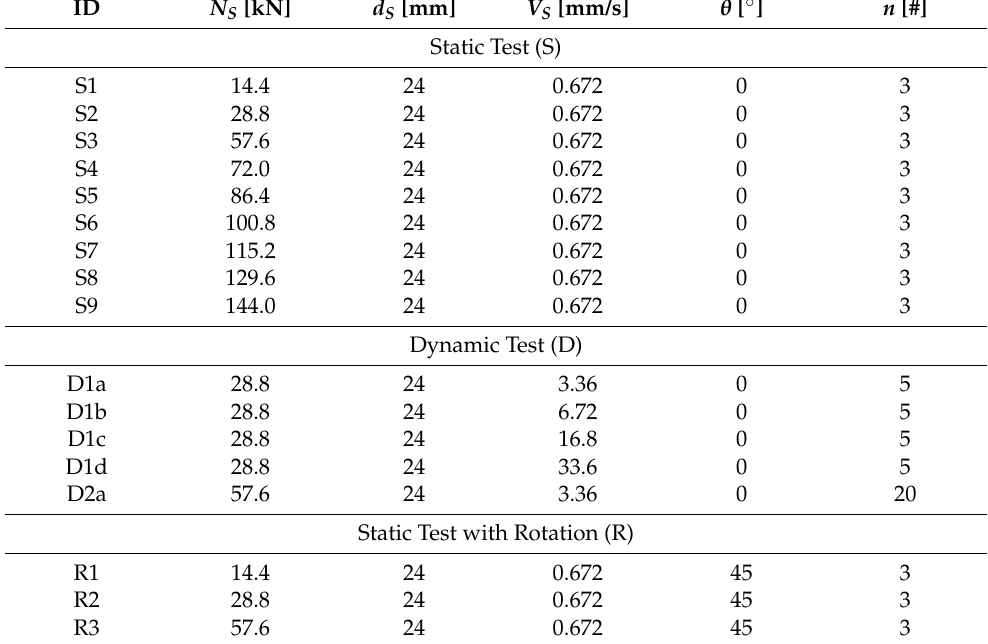
Parameters N S , d S , V S , θ are defined in the main text; n is the number [#] of cycles.